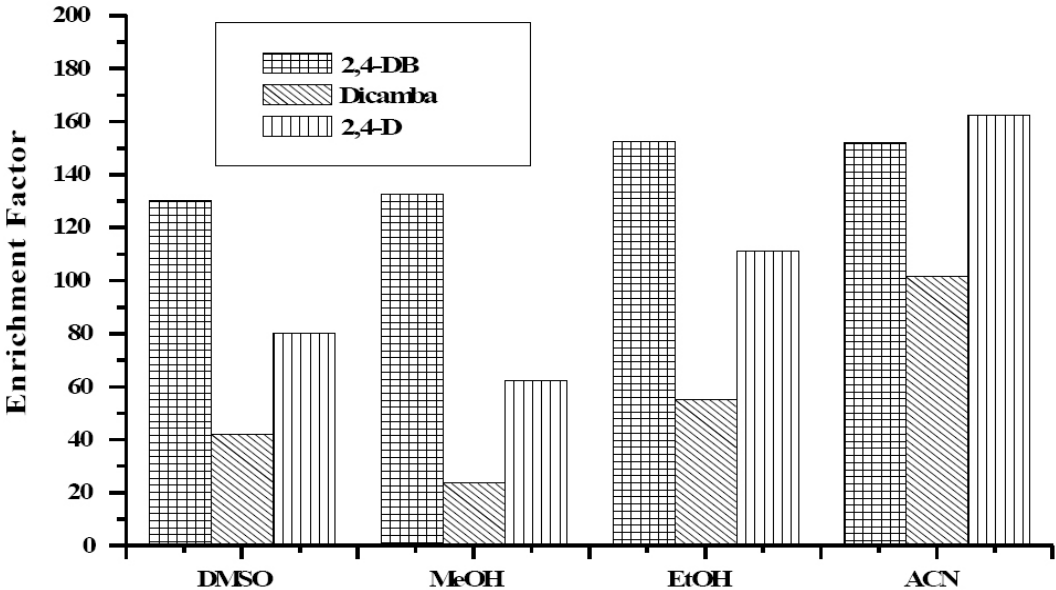
Figure 2. Selection of different dispersing solvent for the DLLME of PAs. Extraction conditions: sample volume, 5.0 mL; extracting solvent, 180 µL chlorobenzene; dispersing solvent, 1000 µL ACN. Optimum MEKC separation conditions: running buffer, 10 mmol L -1 Na